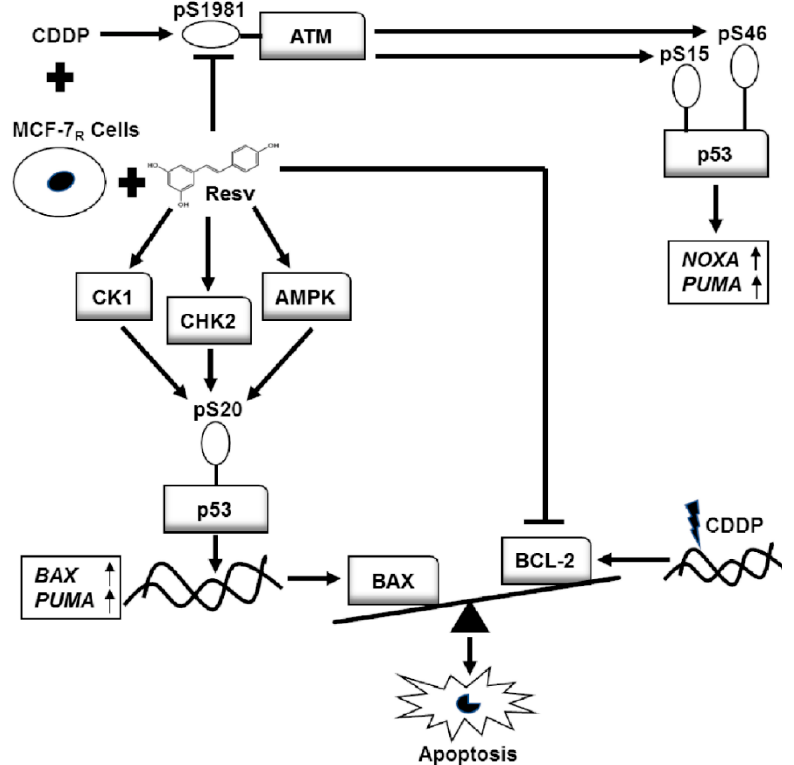
Figure 8. In the MCF-7 resistant cell variant (MCF-7 R ), Resv attenuates phosphorylation in S15 and S46 of p53 by dephosphorylation and deactivation of ATM. However, it activates kinases CK1, CHK2, and AMPK to induce phosphorylation of p53 in S20 (which is required to activate p53 in order to upregulate BAX and PUMA genes) and modifies the ratio between BCL-2/BAX expression. The BAX protein was increased while BCL-2 protein was decreased, restoring apoptosis and overcoming chemoresistance. On the other hand, the overexpression of BCL-2 in MCF-7 R cells after CDDP treatment maintains the chemoresistance and blocks apoptosis despite the phosphorylation of p53 in S15 and S46 and the upregulation of NOXA and PUMA